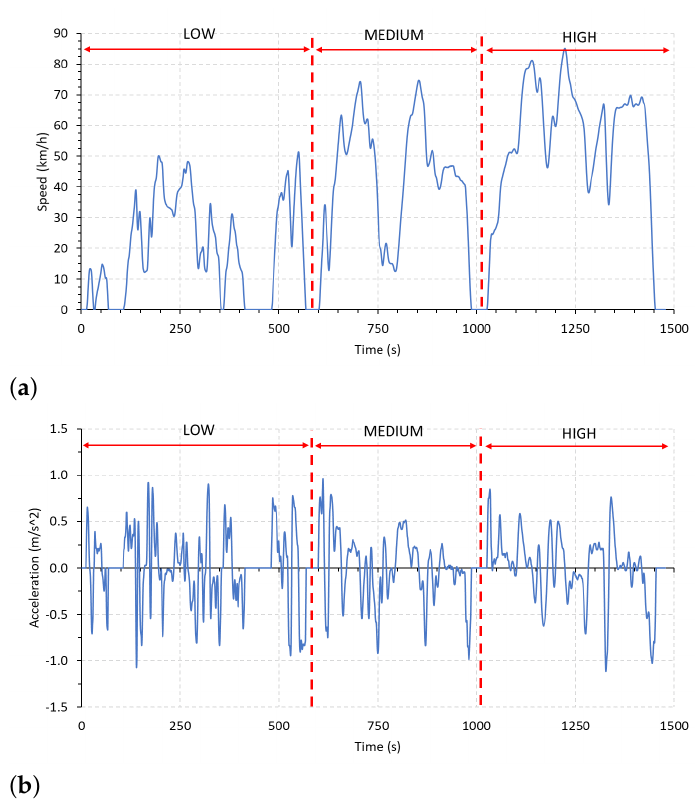
Figure 4. WLTP class 2 driving profile: ( a ) speed; ( b )